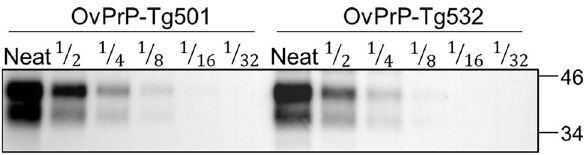
Figure 1. Brain PrP C expression in OvPrP-Tg501 and OvPrP-Tg532 mice. Immunoblotting of PrP C detected using 12B2 mAb. Neat sample (10% brain homogenates) and serial dilutions were loaded on 12% Bis–Tris gels. The figure illustrates a representative set of three independent experiments. Relative molecular mass in kDa at the left side. Full-length blots/gels are presented in Supplementary Figure